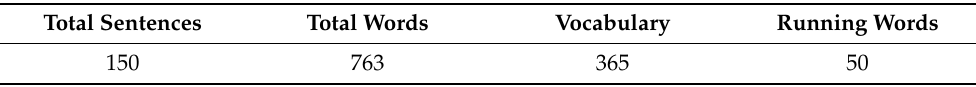
Table 4. Dataset